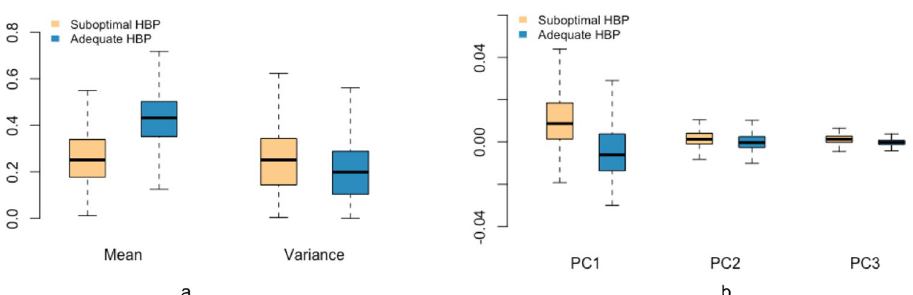
Figure 10. Overall distribution of features extracted from suboptimal and adequate HBP liver MR images with ( a ) GMM, ( b )